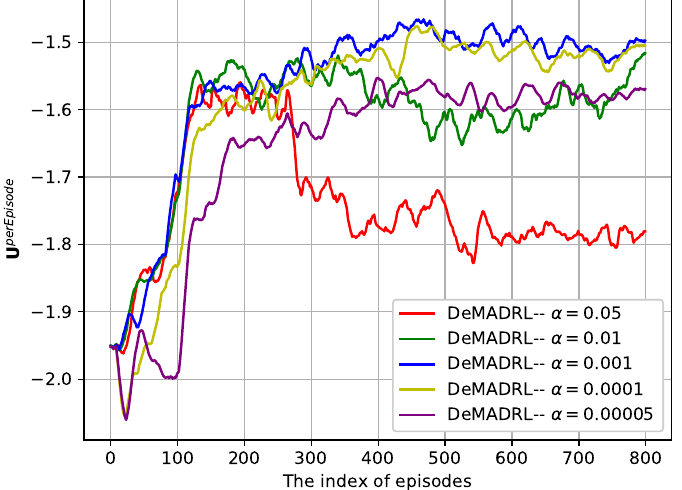
Figure 3. Convegence of DeMADRL with different learning rate α .